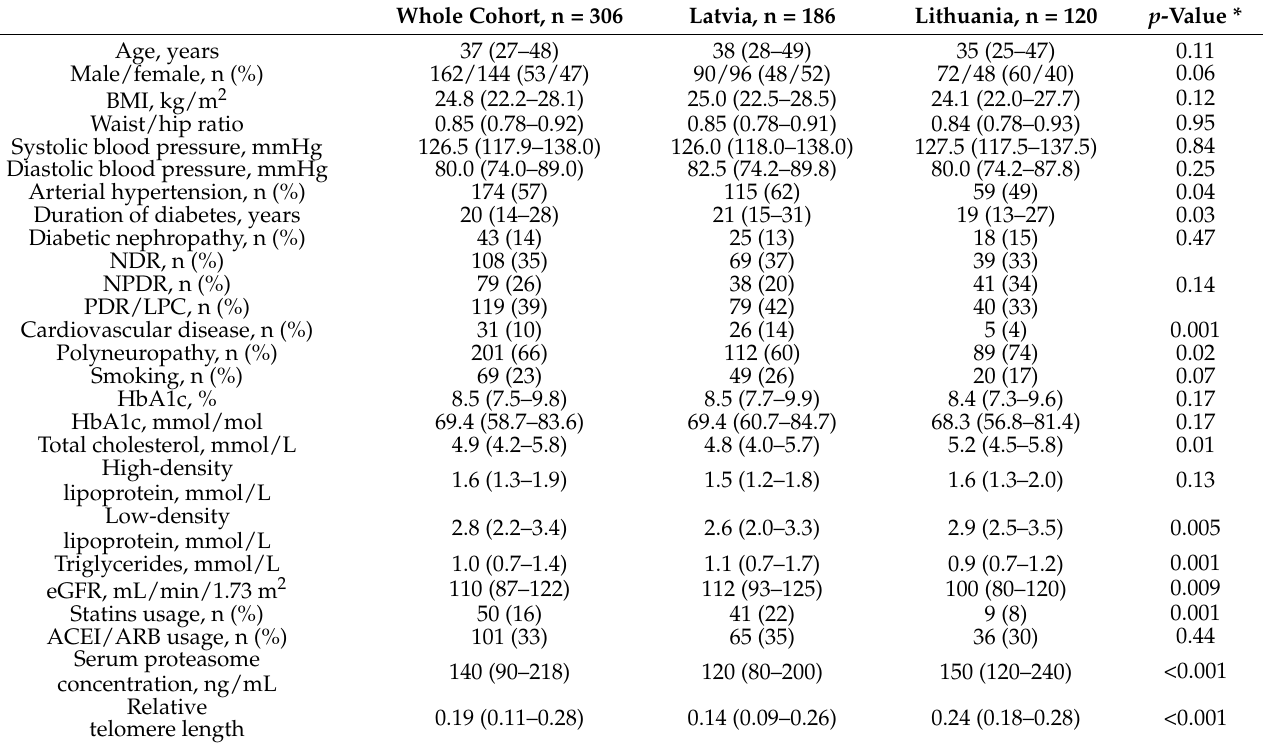
Table 1. Characteristics of the subjects. Whole Cohort, n =